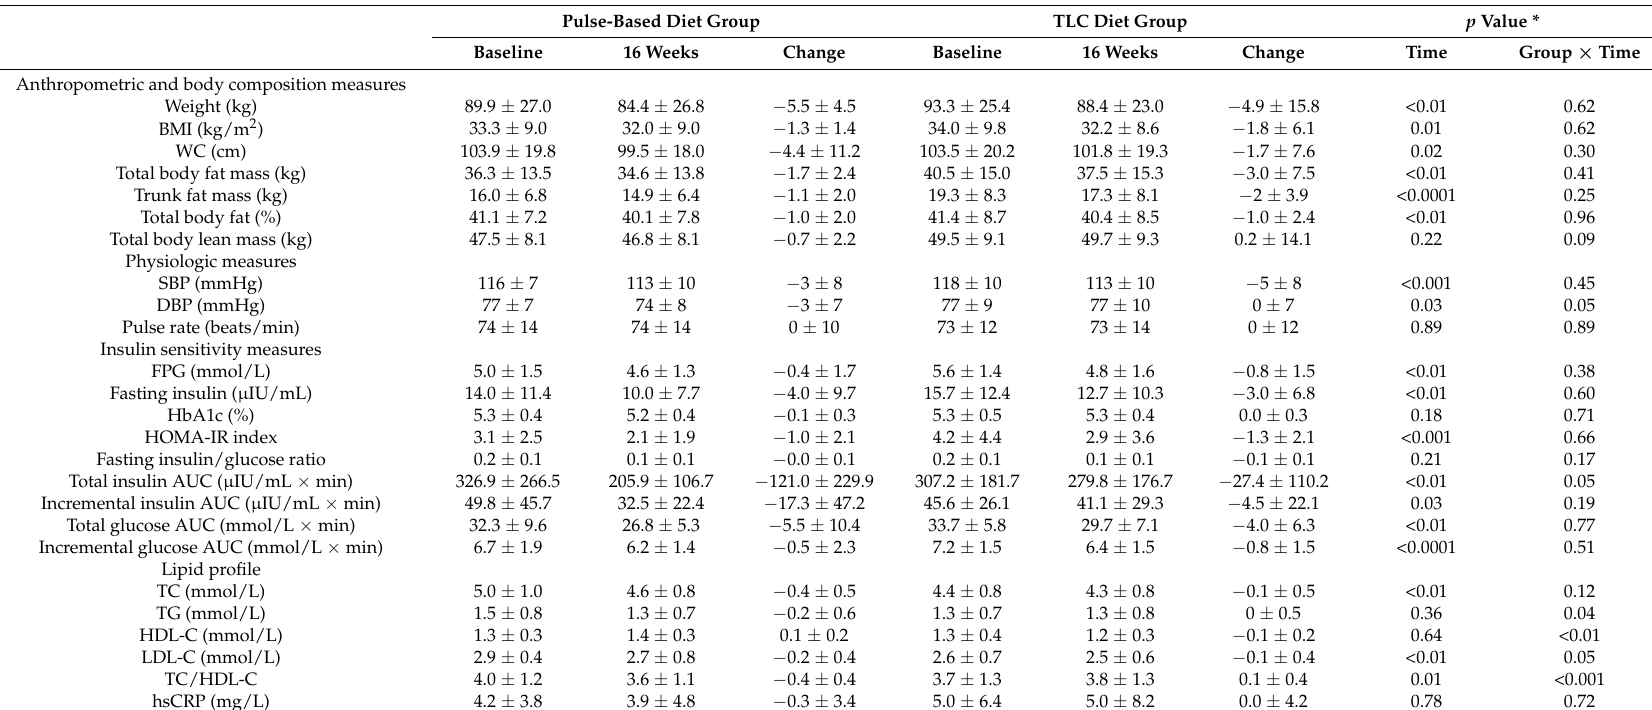
Table 2. Cardio-metabolic outcomes at baseline and after 16 weeks of